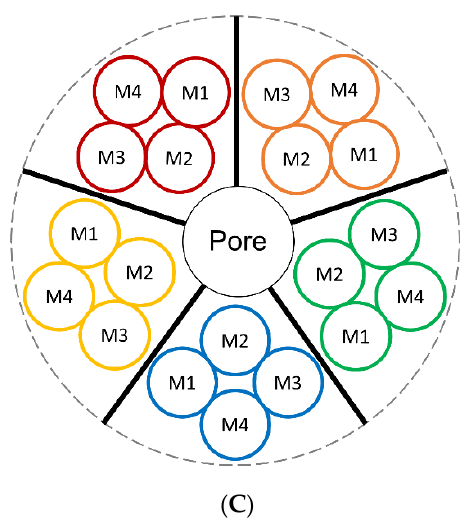
Figure 1. Human nAChR structure and assembly. ( A ) Homomeric and heteromeric nAChR complexes assemble as solely α -subunits or α / β -subunits, respectively. Homomeric nAChRs possess five agonist binding sites at each α - α interface while heteromeric nAChRs possess two agonist binding sites at the α - β interface but can still be weakly activated by ‘non-canonical’ sites at the α - α interface (if present). X indicates other subunits may be present. ( B ) Single nAChR subunit topology consists of an extracellular domain, four transmembrane domains, and an intracellular loop that varies in length depending on subtype. ( C ) Pentameric nAChR complex from a top-side view identifying the formation of the transmembrane domains of individual nAChR subunits with respect to the nAChR central pore.